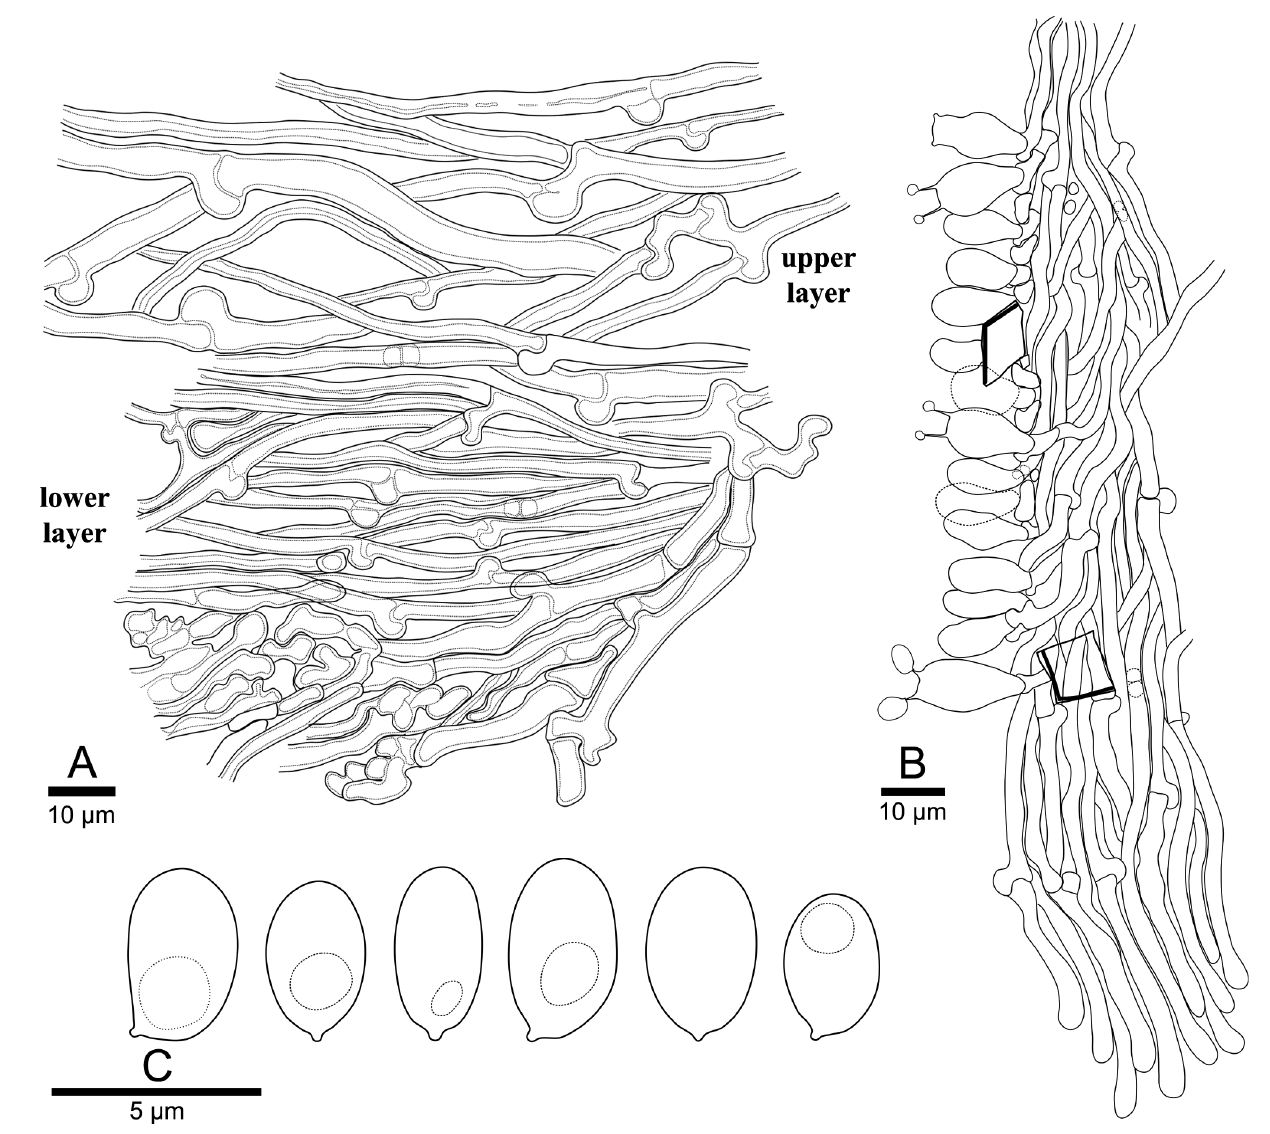
Figure 3 – Microscopic structure of Bjerkandera albocinerea . A . Two-layered context. B . Hymenium and tramal hyphae with